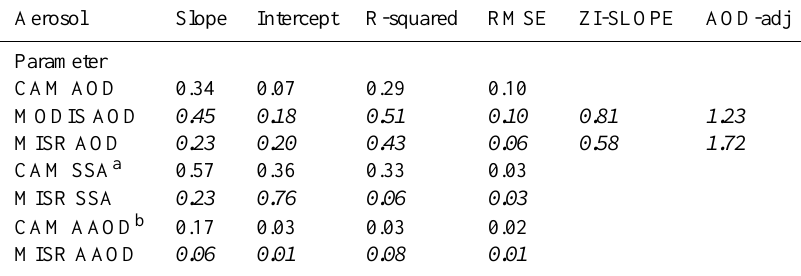
Table A1. Regression of the monthly mean Community Atmosphere Model (CAM) and MODIS and MISR satellite aerosol parameters onto the AERONET observations for all months and all AERONET stations. Coefficients are the slope of the linear regression (Slope), the y-intercept (Intercept), the correlation coefficient (R-squared), the root mean squared error (RMSE), the slope when forced through point (0,0) (ZI-SLOPE), and the adjustment factor for the satellite aerosol optical depth (AOD-adj). Italics represent the results of computations on the subset of observations for which the satellite AOD > 0.2. Aerosol Slope Intercept R-squared RMSE ZI-SLOPE AOD-adj Parameter CAM AOD 0.34 0.07 0.29 MODIS AOD 0.45